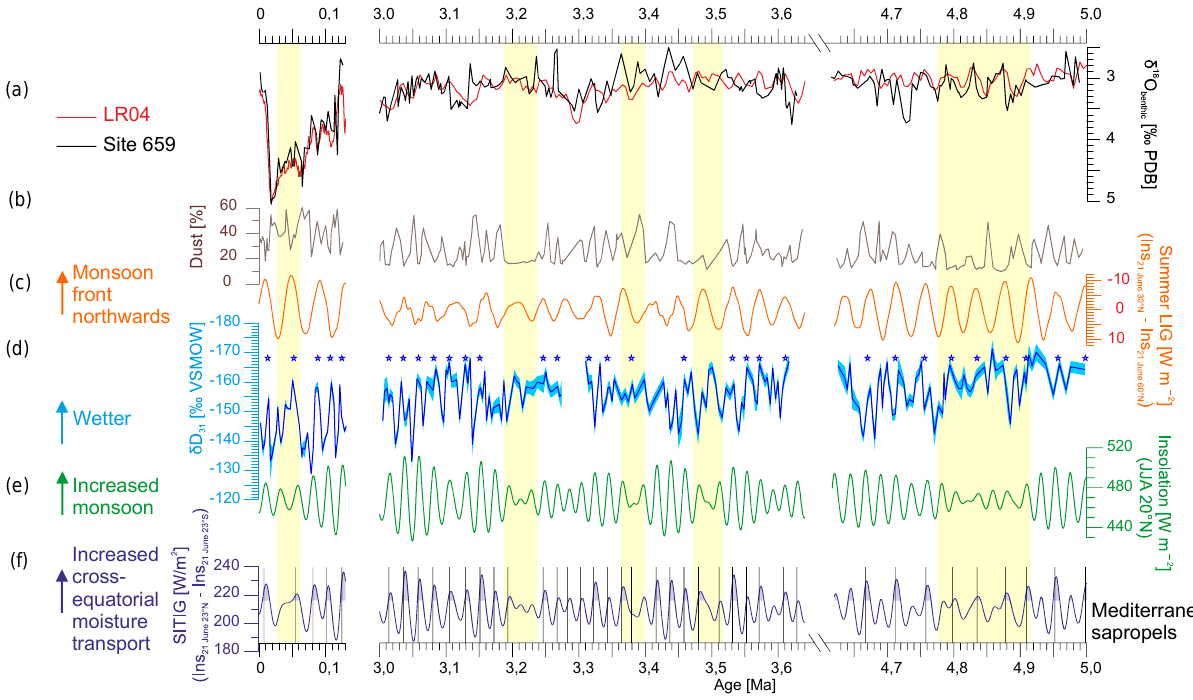
Figure 6. Multiple isolation forcings. (a–f) Stable oxygen isotopes of benthic foraminifers ( δ 18 O benthic ) from ODP Site 659 (Tiedemann et al., 1994) compared to the global stack LR04 (Lisiecki and Raymo, 2005) in per mil vs. Pee Dee Belemnite (PDB); dust percentages after (Tiedemann, 1991); summer latitudinal insolation gradient (LIG) calculated from the 21 June insolation at 30 ◦ N minus that of 60 ◦ N; stable hydrogen isotope composition δ D 31 in per mil vs. Vienna Standard Mean Ocean Water (VSMOW) for the last glacial cycle after Kuechler et al. (2013) and for the Pliocene (this study) – stars indicate δ D 31 minima associated with Mediterranean sapropels; summer insolation (June, July, August) at 20 ◦ N; cross-equatorial summer inter-tropical insolation gradient (SITIG) calculated from the 21 June insolation at 23 ◦ N minus that of 23 ◦ S and occurrence of Mediterranean sapropels (Emeis et al., 2000). Insolation values from http://vo.imcce.fr/insola/ earth/online/earth/online/ (Laskar et al., 2004). Yellow shading denotes periods with low precession